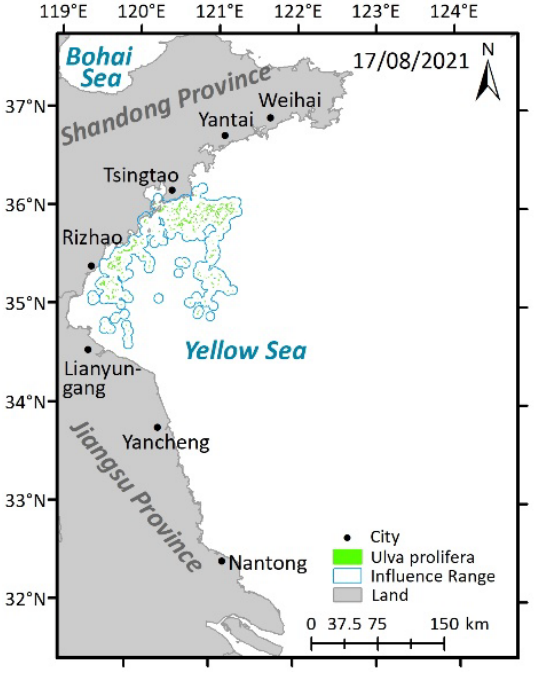
Figure 7. Spatio-temporal distribution of U. prolifera in the Yellow Sea in 2021.